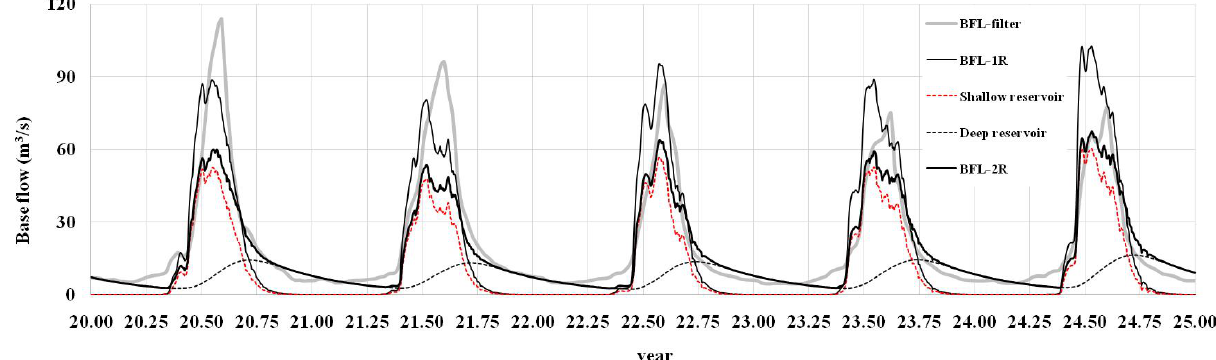
Fig. 5. Clip illustration of the seasonal baseflow processes generated by model- and filter-based approaches, the whole period covered 1961–1999, 1961 as the year 1 (BFL=baseflow; filter=filter-based baseflow separation program; 1R=one-reservoir approach; 2R=two- reservoir approach; Shallow reservoir=the shallow aquifer reservoir generated baseflow; Deep reservoir=the deep aquifer reservoir generated baseflow).